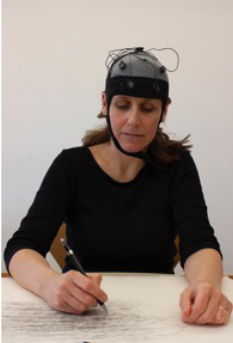
Figure 1 | Enhancing the Mind’s I . Detail; Laboratory research, Porto, (Portugal). (The author, in collaboration with